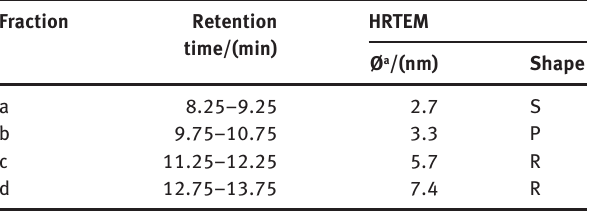
Table 2 Retension time and properties of the collected